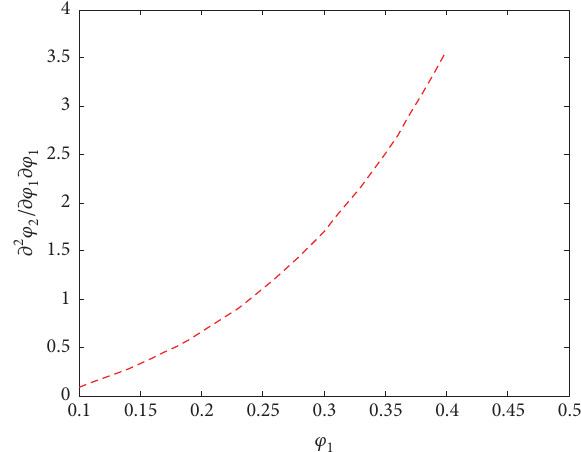
Figure 3: The relation between supervision cost and the price for carbon emission right with 𝑁 = 100000 ; ℎ = 0.7 ; 𝜏 𝜇 = 5 ; 𝜑 1 = 0.5 ; 𝑢 = (2, 8) .